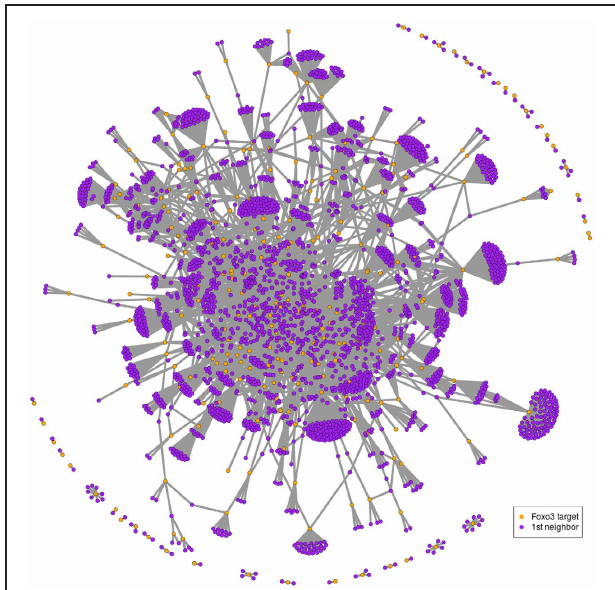
FIGURE 1 | Example of FOXO3-interaction network. Putative FOXO3 targets (orange nodes) as indicated by studies in mouse NSCs (Paik et al., 2009; Renault et al., 2009) with their first-degree neighbors (violet nodes) as inferred from the probabilistic functional network STRING. This corresponds to 255 FOXO3 targets that have 2689 first neighbors in STRING (confidence score greater than 0.7) out of the 374 putative targets initially identified by the Paik et al. and Renault et al. studies. The confidence score was set at 0.7 to ensure clarity of the graph. Biological content is illustrated in Figure S1